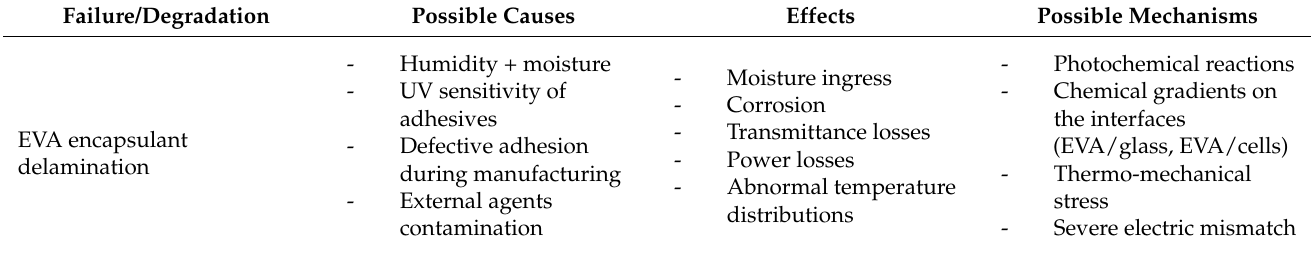
Table 4. Summary of the failure/degradation modes studied in this work, with their possible causes, visible/measurable effects on the modules and possible mechanisms, according to the literature